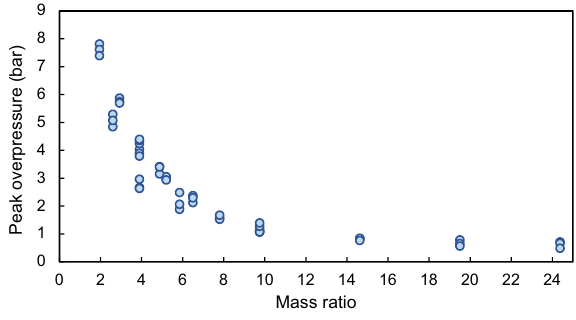
Figure 14. Effect of mass ratio on peak overpressure